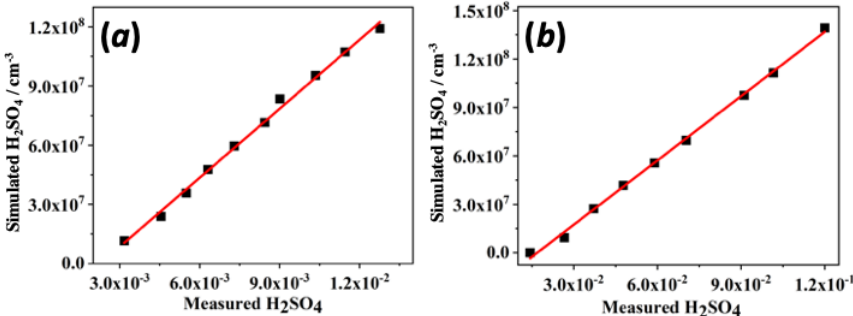
Figure 3. Sulfuric acid (H 2 SO 4 ) calibration plots showing the simulated values in moleculecm − 3 against the measured, normalized ion signals determined for (a) Br − ion mode and for (b) NO − ion mode. For the ion signal to concentration conversion see the Supplement. 3 mixed with the bath gas air (N 2 + O 2 ) and ozone (O 3 ,